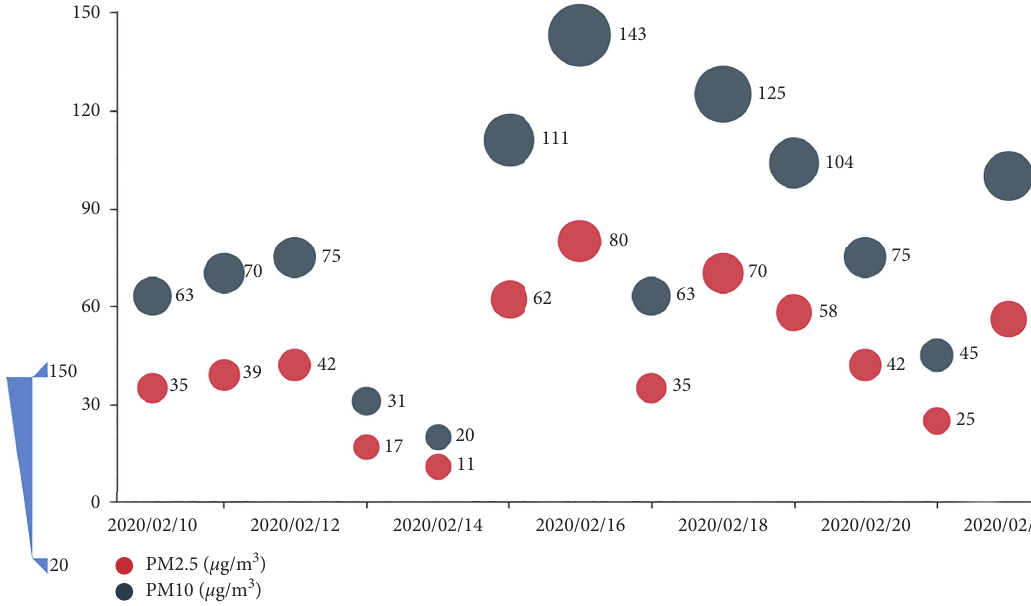
Figure 10: Data changes of PM2.5 and PM10 in a period.